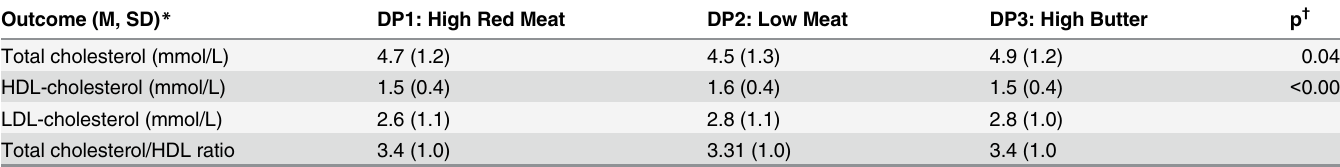
Table 3. Blood lipid profile of study participants by dietary patterns.